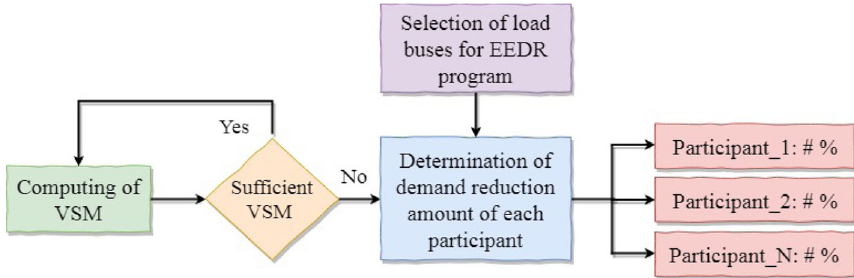
Fig. 5 Framework of the proposed EEDR strategy